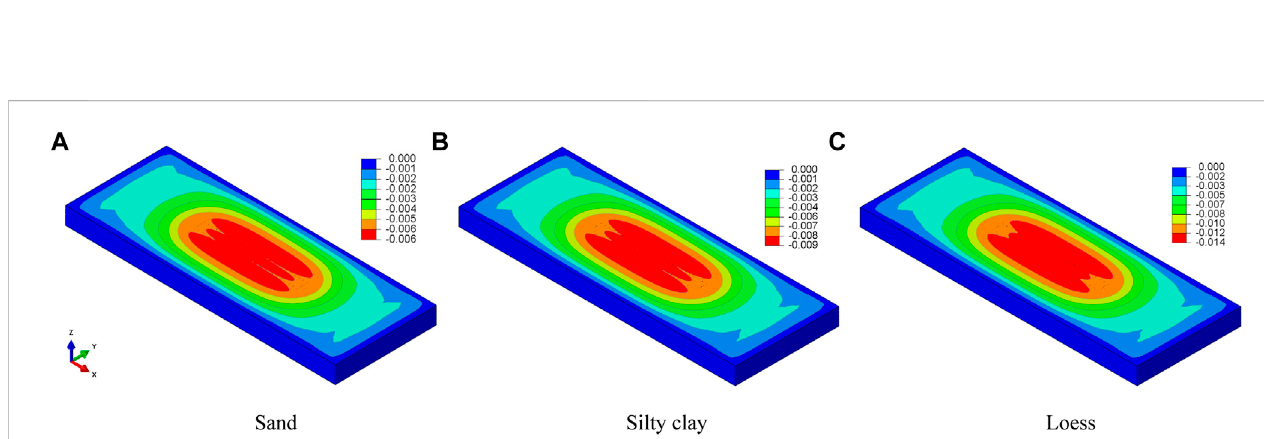
FIGURE 6 Settlement deformation contour after dewatering (Unit: m) (A) Sand (B) Silty clay (C) Loess.